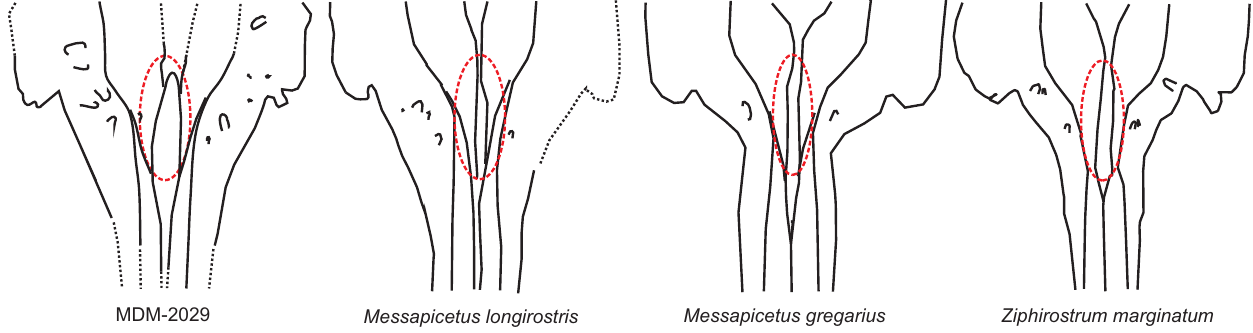
Fig. 10. Comparison of the dorsal view of the preserved cranium of Messapicetus cf. longirostris (MDM-2029) with some stem beaked whales. The dotted ovals indicate the extent of the prenarial